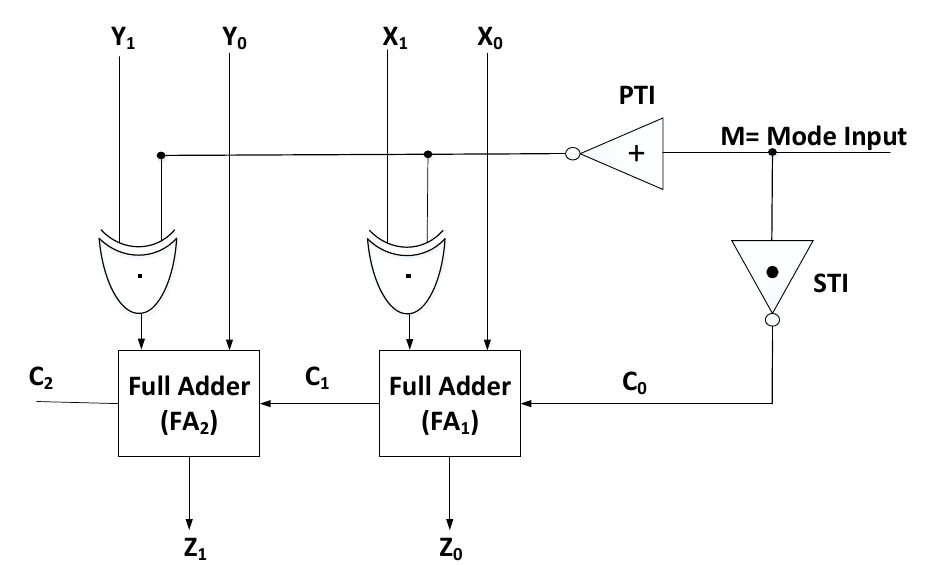
Figure 8. Design implementation of CNTFET-RRAM ternary